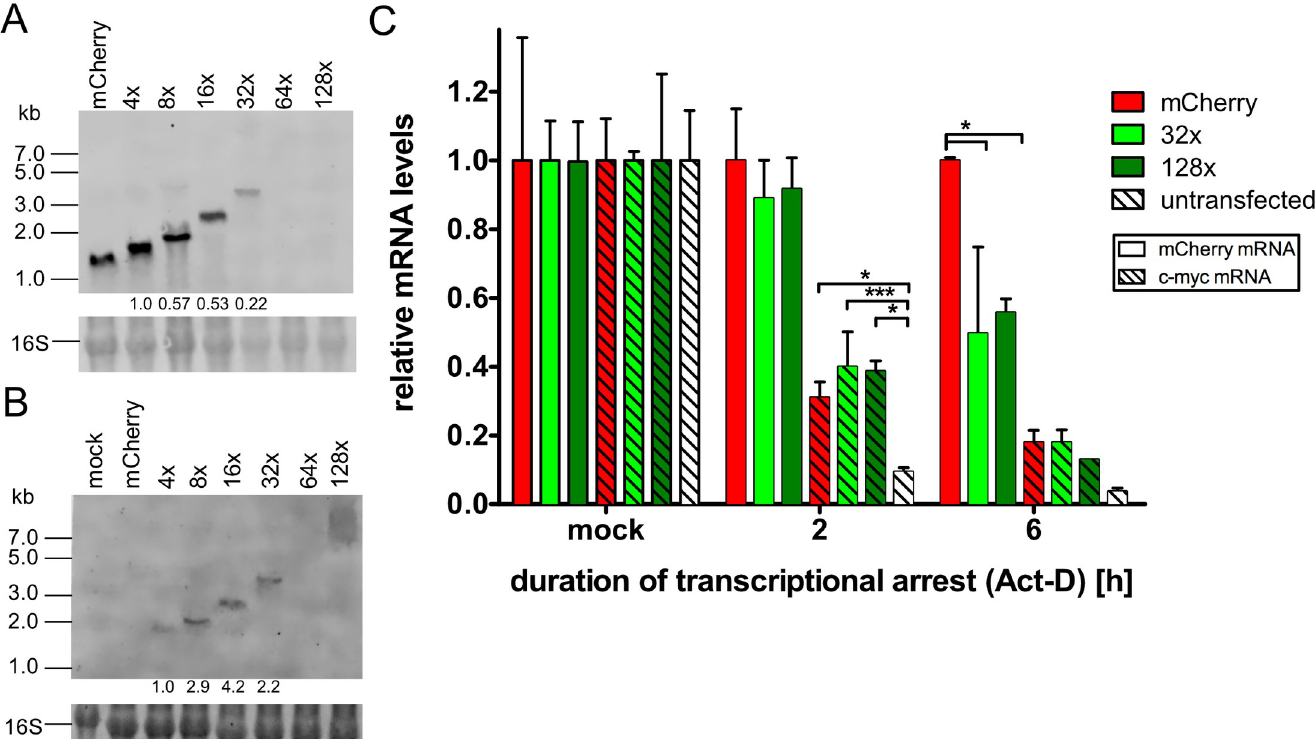
Fig 4. RNA of Broccoli is detectable up to 32 copies by Northern blot. 293T cells were transfected with mCherry or Broccoli plasmids and 10 μ g of isolated total RNA loaded on a denaturing gel for Northern blot. A fluorescently-labelled probe against mCherry (A) or Broccoli (B) was used to detect the respective RNAs. Intensities of mCherry and Broccoli RNA bands were measured using arbitrary values and normalized to either mCherry (A) or 4xBroccoli (B). 16s RNA was stained using ethidium bromide. (C) 293T cells were transfected with mCherry, 32x and 128x Broccoli plasmids. 24hours post-transfection, cells were collected (mock) or treated with actinomycin D for 2 or 6 hours. RNA was isolated at each time point and RT-qPCR performed for detection of mCherry and c-myc. Empty bars show mCherry transcription levels, striped bars represent c-myc transcription levels. Statistical analysis performed by 2-way ANOVA. � P < 0.05, �� P < 0.01, ��� P < 0.001.